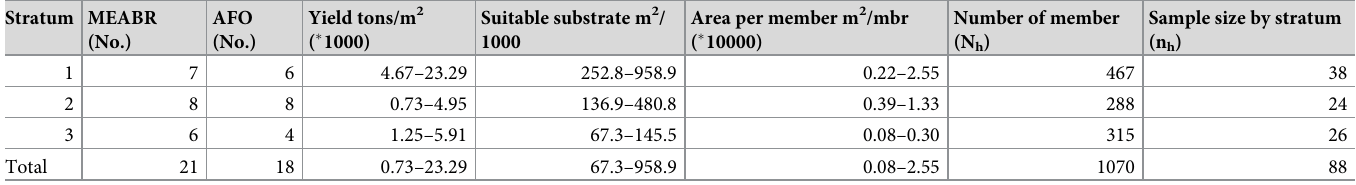
Table 2. Classification and sample sizes of selected MEABRs by stratum. Stratum MEABR